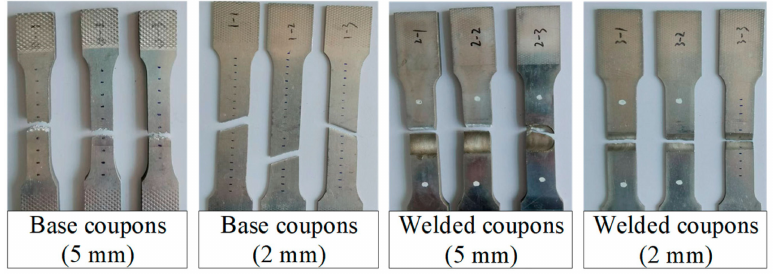
Figure 5. Failure modes of coupons.